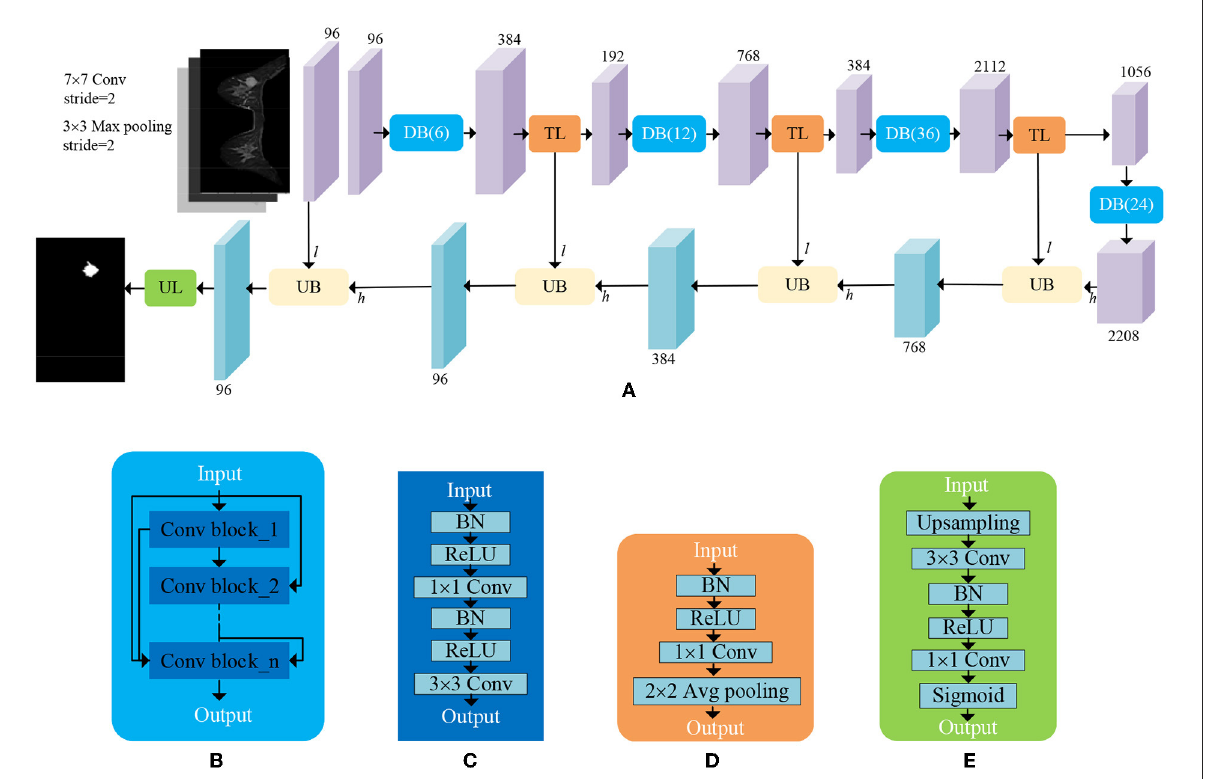
FIGURE5 An illustration of ADUNet. (A) The architecture of ADUNet; (B) Dense Block (DB(n)); (C) Convolutional Block; (D) Transition Layer (TL); (E) Upsampling Layer